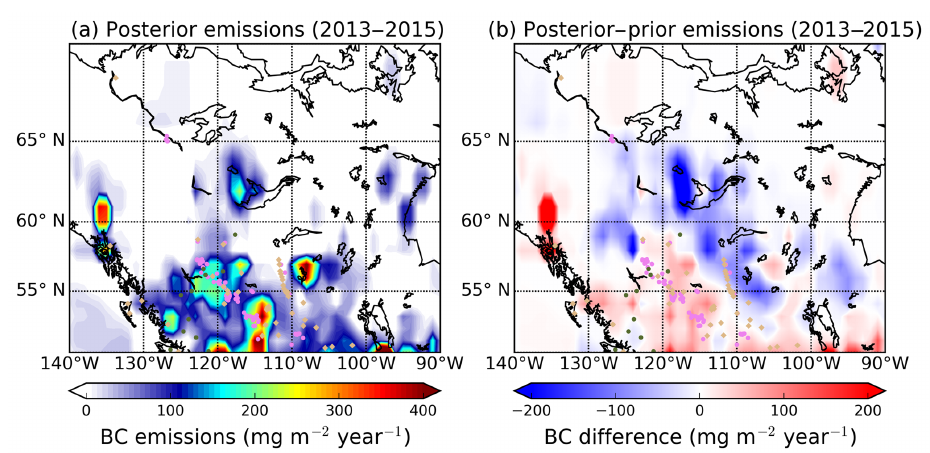
Figure 10. (a) Optimised emissions of BC in North America (western Canada) averaged over the 2013–2015 period. (b) Difference between a posteriori and a priori emissions of BC (ECLIPSEv5 was used as the prior). Magenta points on the map denote the gas flaring indus- tries from the Global Gas Flaring Reduction Partnership (GGFR) (http://www.worldbank.org/en/programs/gasflaringreduction, last access: 29 February 2017), grey points show the power industries that operate using fossil fuels and oil and gas production and oil-refining industries adopted from Industry About (https://www.industryabout.com/canada-industrial-map, last access: 29 ebruary 2017), and dark green points show active fires from